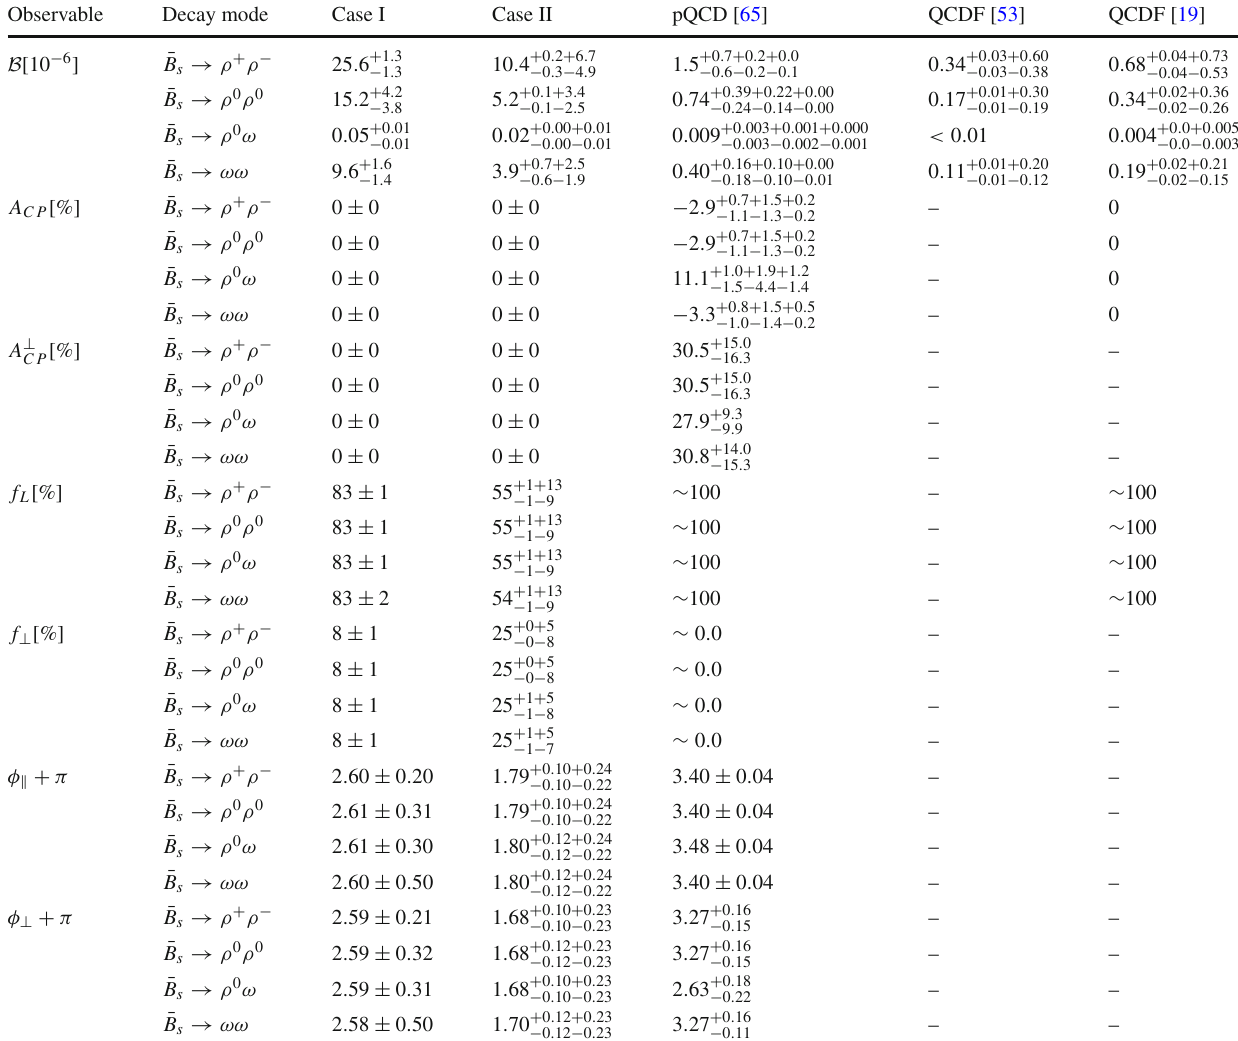
Table 6 Theoretical results for pure annihilation ¯ B s → ρρ , ρω and ωω decays. Our results A 0 previous ones and are, therefore, not listed here